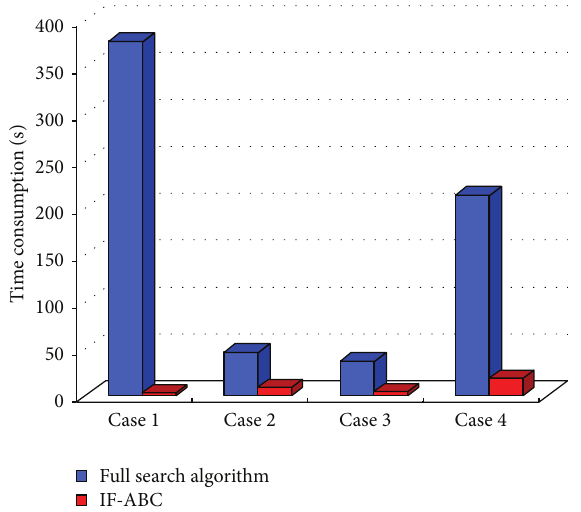
Figure 7: Comparisons of time consumptions between full search algorithm and IF-ABC in four ideal